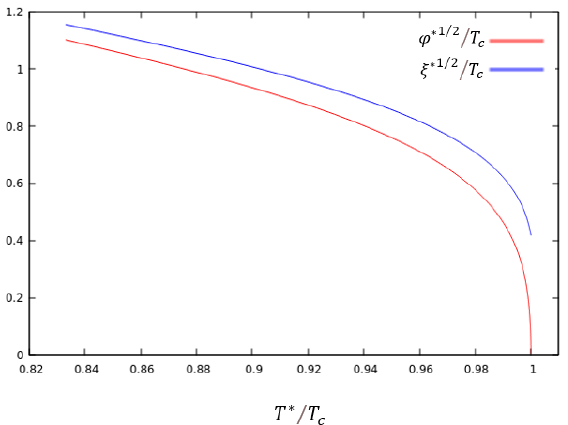
Figure 1. The dimensionless condensates ϕ 1/2 + / T c and ξ 1/2 + / T c associated with the scalar field ϕ (red) and ξ (blue), respectively, as functions of T ∗ / T c , where T c is the temperature at which condensation sets in for ϕ . Here, (cid:101) = λ = 0, i.e., the two condensates do not interact. Note, that the curve in ξ (blue) ends at a temperature below its own condensation temperature, since the numerical parameter used to construct the curves is the value of the field ϕ